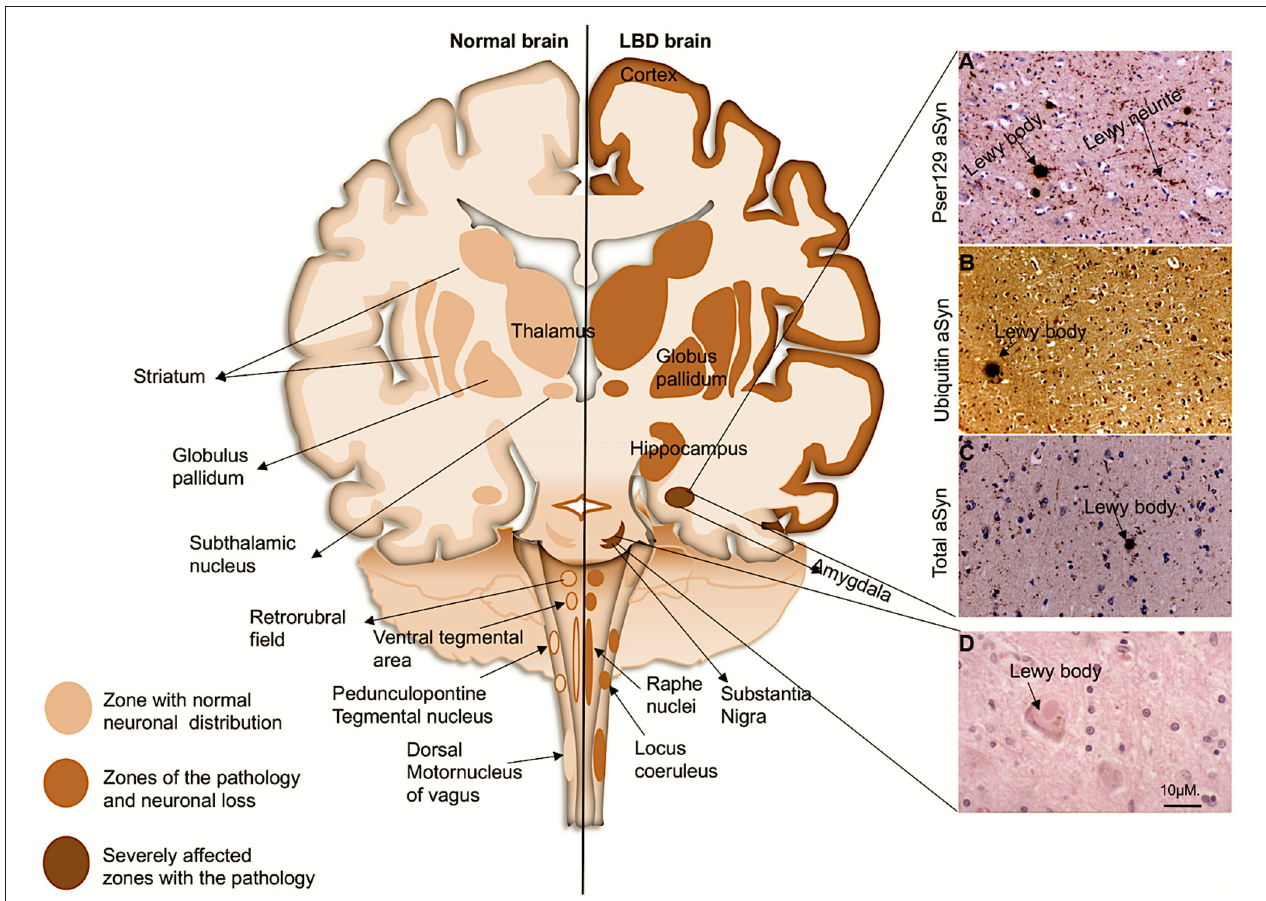
FIGURE 1 | Coronal schematic of the brain, depicting normal structures and in LBD subjects. Shading shows the distribution of aSyn in LBs/LNs in cortical and subcortical regions. Subcortical regions are associated with PD, and as the disease progresses to cortical regions it corresponds with DLB and PDD. (Right, A–D ): LB pathology (arrows) revealed in the amygdala of a patient with DLB with antibody to pSer 129 aSyn (A) , ubiquitin (B) , and whole aSyn counterstained with haematoxylin. (D) , LB with a halo typically found in the substantia nigra. Magnification bar: 10 µ